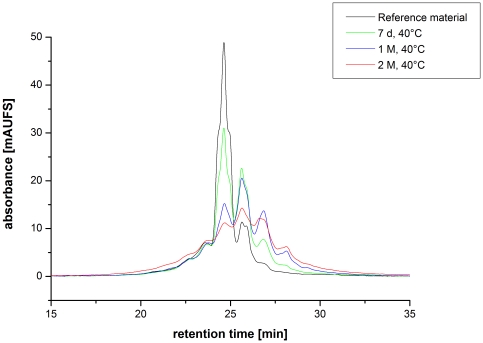
Cation-exchange chromatography of Mab1 reference material versus selected stressed samples (stored at 40°C; 7 days, 1 and 2 month).